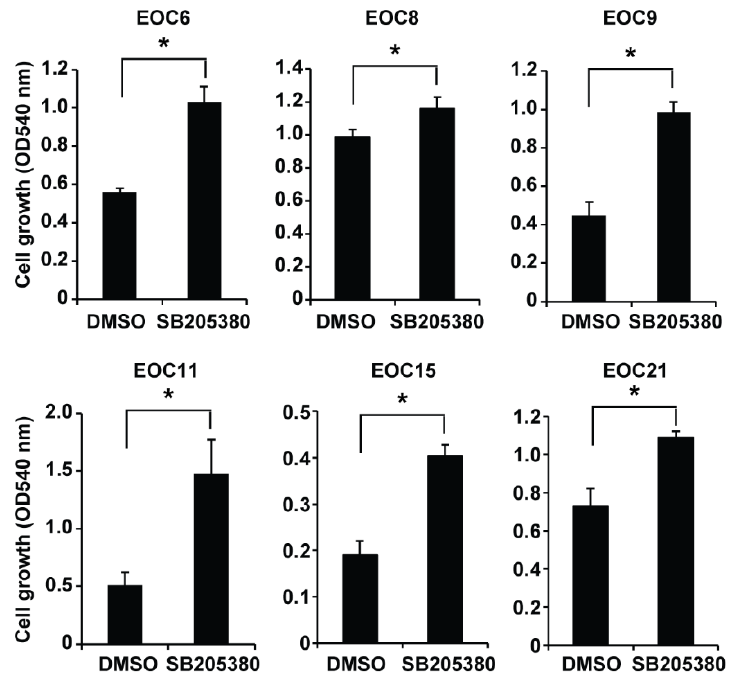
Figure 6. Inhibition of p38 MAPK by SB203580 increases the number of viable cells in the primary EOC cells cultured in spheroids. Primary EOC cells were cultured in spheroids in 24 ‐ well low attachment plates (50,000 cells/well) and treated with 10 μ M SB203580 or an equal volume of DMSO (the vehicle control) for three days. The number of viable cells was determined using the neutral red uptake assay and shown as absorbance at 540 nm. Data are shown as mean ± SD of three spheroid cultures. * Significantly different ( p < 0.05).